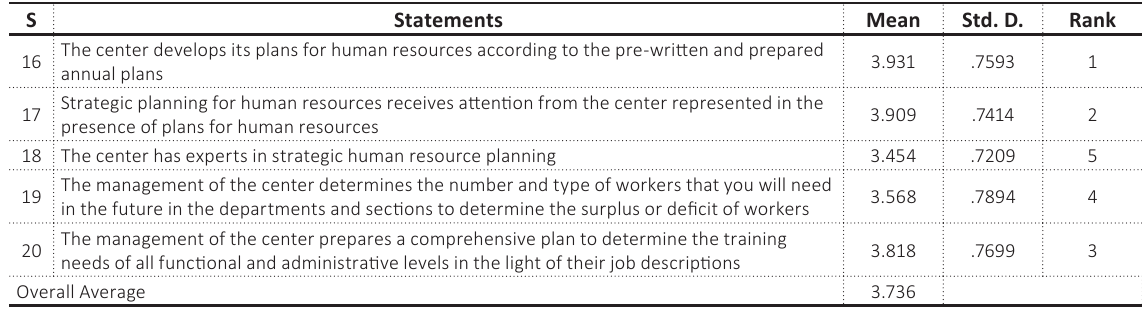
Table 4. Means and standard deviations of the development human resources action plans variable